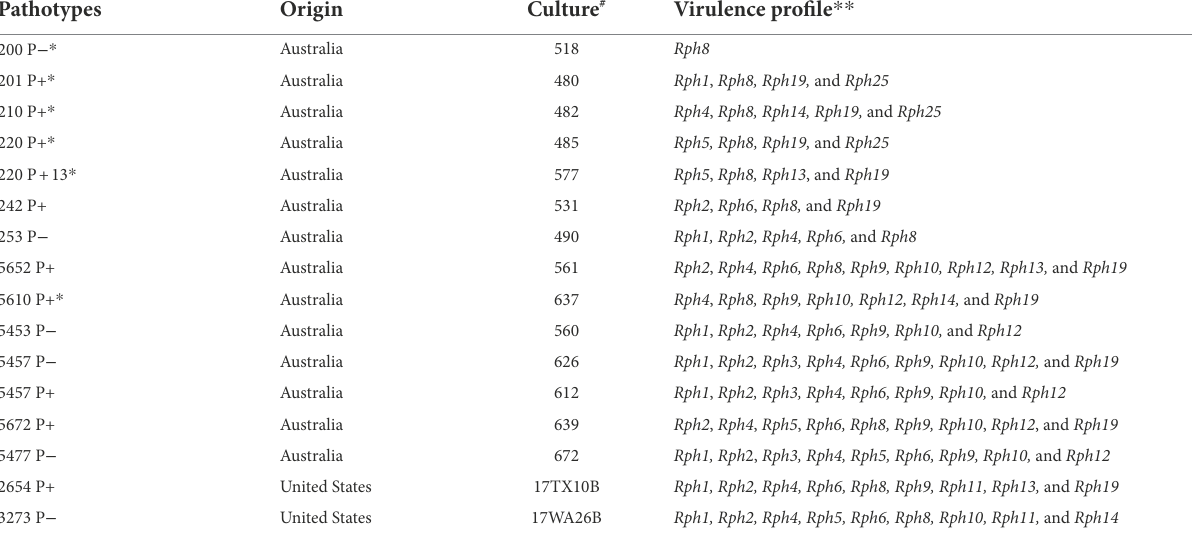
TABLE 1 Puccinia hordei pathotypes used in this study, along with origin and their virulence profile.